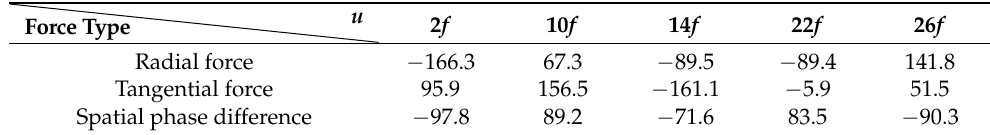
Table 3. Spatial phase of the minimum non-zero spatial order force density under loading operation of a 14-pole 12-slot PMSM (unit: ◦